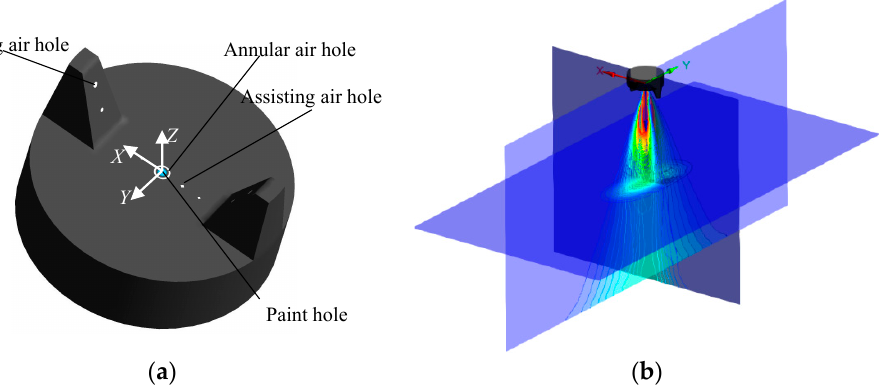
Figure 2. Geometry of the nozzle adopted ( a ) and its spray flow ( b ).